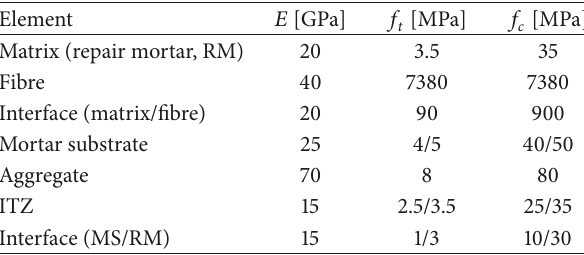
Figure 6: (a) Aggregates in the concrete substrate generated by Anm model [22]; (b) two-dimensional overlay procedure for generation of the lattice model in interface zone between aggregate and substrate mortar (ITZ) [23]. Table 3: Input values for lattice fracture model ( 𝐸 stands for the modulus of elasticity, 𝑓 𝑡 stands for the tensile strength, and 𝑓 𝑐 for the compressive strength of